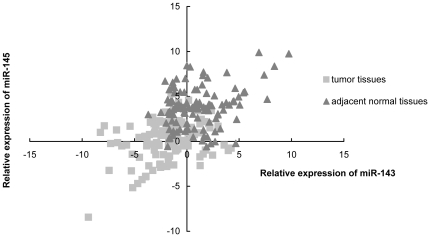
Scatter plot of miR-143 and miR-145 expression in ESCC patients.Relative expression of miR-143 and miR-145 normalized by U6 were evaluated with Pearson correlation analysis. Square represents samples from tumor tissues and triangle represents samples from normal tissues adjacent to tumor. The mixed sample set showed a significantly positive correlation between miR-143 and miR-145 expression.